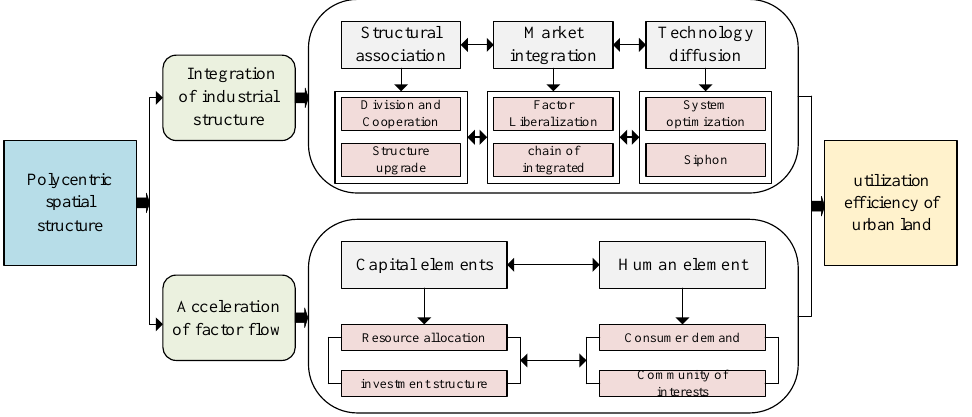
Figure 1. Diagram of the intermediary